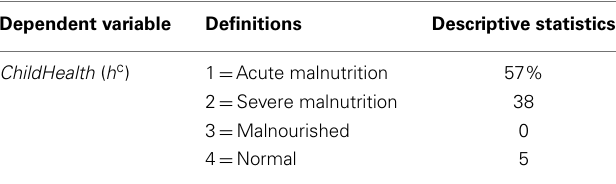
Table 1 | Descriptive statistics ( n = 2,190) .